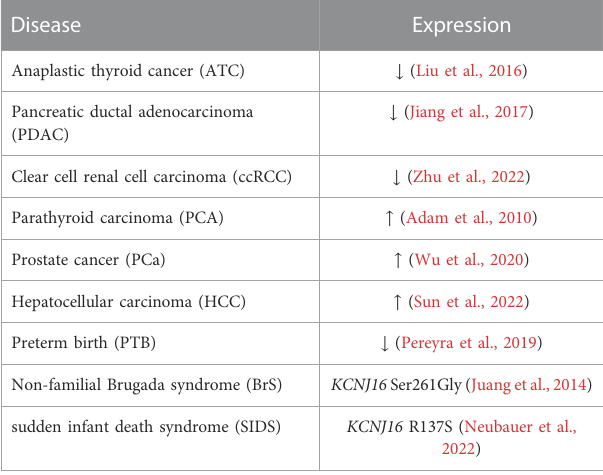
TABLE 1 Expression changes of Kir5.1 as a differentially expressed gene in human